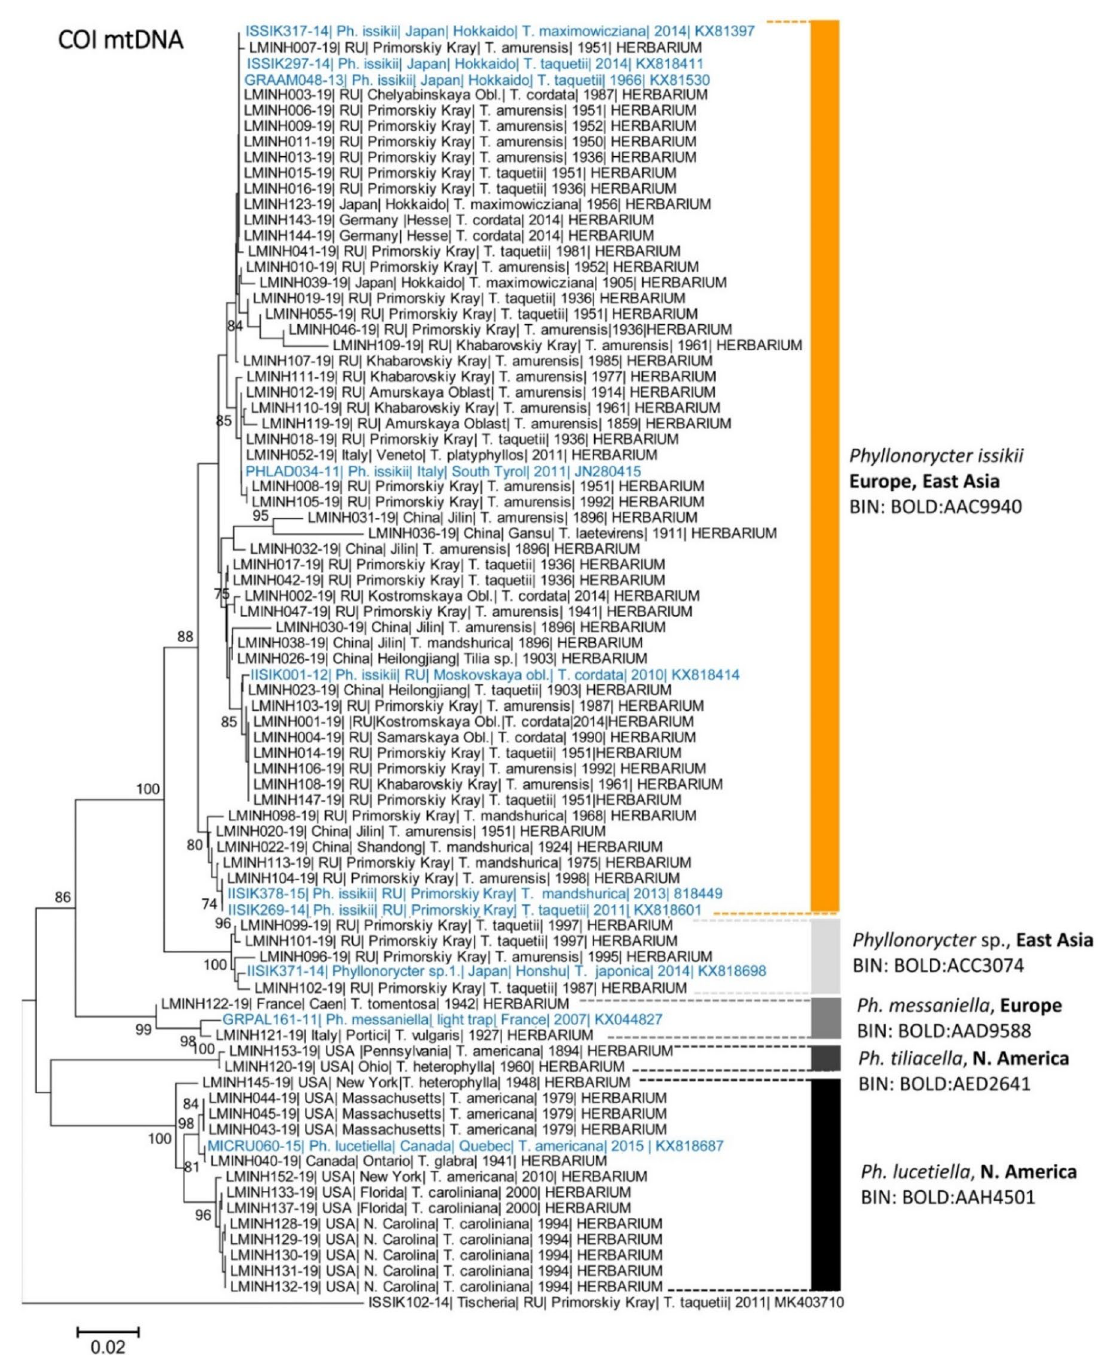
Figure 5. A maximum likelihood tree of 81 COI sequences of Phyllonorycter spp. Overall, 71 archival sequenced specimens were dissected from herbaria collected in the Palearctic and the Nearctic in 1859–2014 and ten specimens (highlighted in blue) originated from the modern range 20 . The tree was generated with the K2P nucleotide substitution model and bootstrap method (2500 iterations), p < 0.05. Each specimen is identified by its unique Process ID | country | region | host plant | sampling year | GenBank accession number (for modern sequences) or an indication of the source of the material (HERBARIUM) for archival specimens. Each genetic cluster is specified by its Barcode Index Number (BIN) (given next to each cluster). Branch lengths are proportional to the number of substitutions per